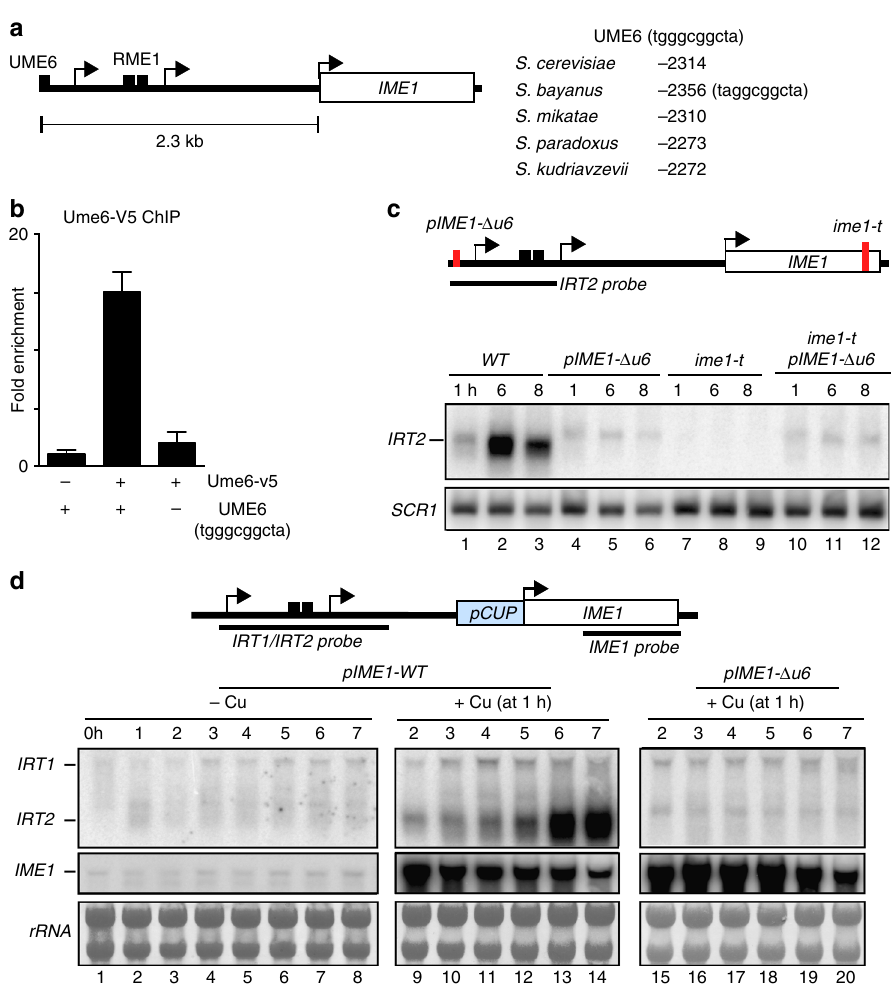
Fig. 3 Ime1 and Ume6 control IRT2 expression. a Schematic overview of the IME1 locus indicating the position of the Ume6-binding site (left). Nucleotide coordinates of the Ume6 site relative to IME1 AUG in different Saccharomyces species (right). b Binding of Ume6 to the IME1 promoter measured by chromatin immunoprecipitation using V5 tagged Ume6 (FW2978). A wild-type (FW1509) and an Ume6-binding deletion mutant ( pIME1- Δ u6 , FW2000) strains were also included in the analysis. The means ± SEM of n = 3 experiments are shown. c Northern blot of IRT2 expression in cells that were pre- grown in rich medium and pre-sporulation medium, before shifted to SPO. Wild-type (FW1511), single, and double mutants harboring pIME1- Δ u6 and/or a 3 ′ end mutation in IME1 ( ime1-t ) (FW2449, FW2370, and FW2571) strains were used for the analysis. To control for loading, the membrane was also probed for SCR1 . d IRT1 , IRT2 , and IME1 expression detected by northern blot in cells expressing IME1 from the copper-inducible promoter ( pCUP-IME1 , FW3006). pIME1- Δ u6 (FW2842) cells were also included in the analysis. Cells were pre-grown in rich and pre-sporulation medium before shifted to SPO and were either not treated ( − Cu) or treated with copper sulfate ( + Cu) at 1 h in SPO. Northern blot membranes were hybridized with a probe that detects both IRT1 and IRT2 , and a probe that detects IME1 . As a loading control, the ribosomal RNA is